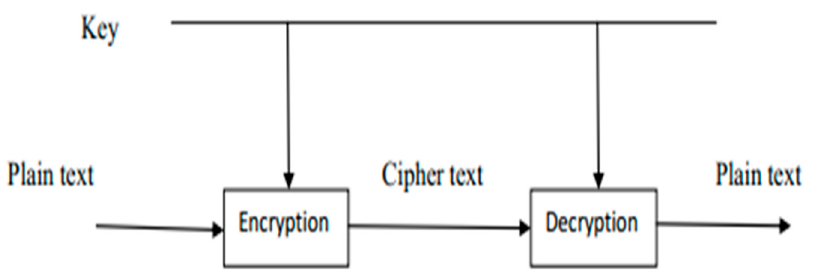
Figure 2. Symmetric key cryptography.